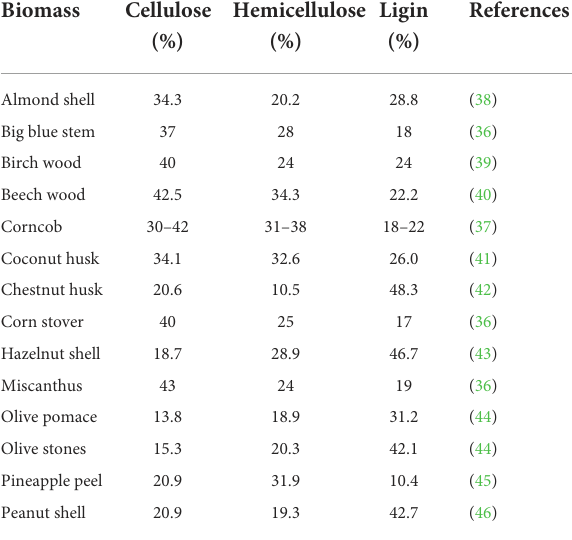
TABLE 1 Cellulose, hemicellulose, lignin composition in raw lignocellulose biomass.